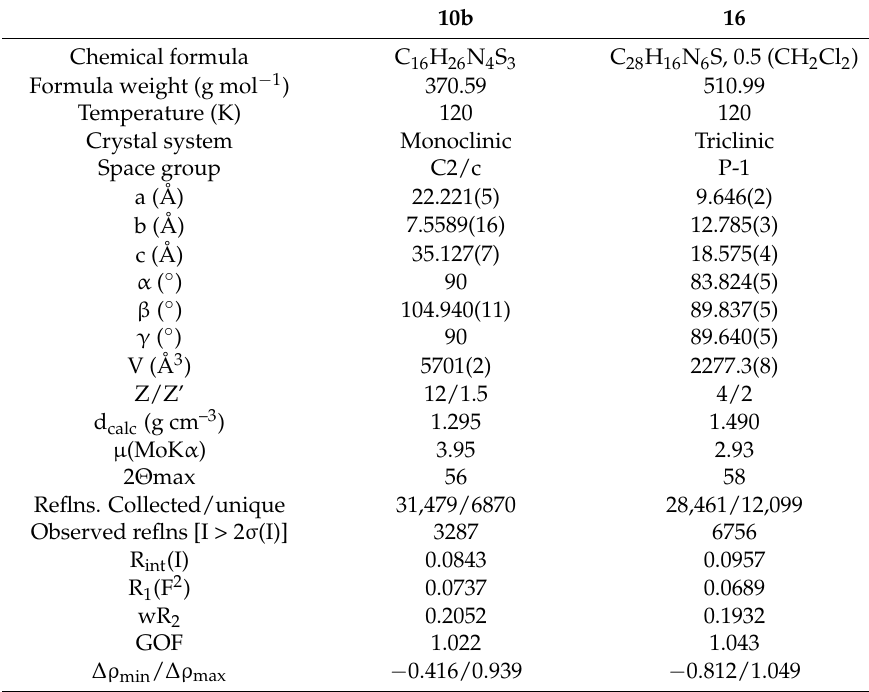
Table 6. Crystallographic data for 10b and 16